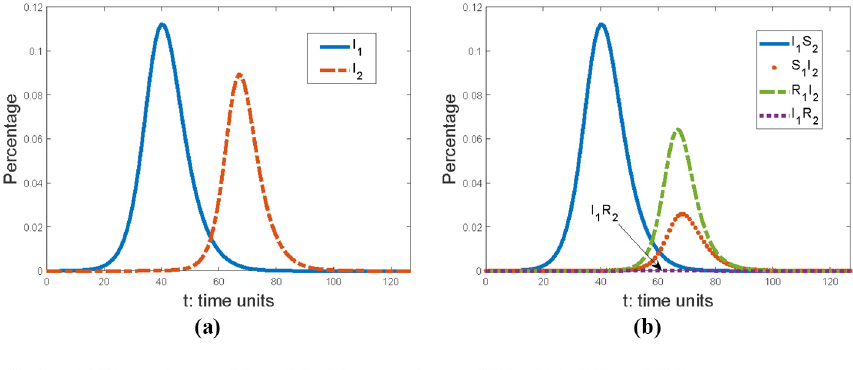
Figure 5. The percentages of (a) I 1 , I 2 and (b) each infectious group over